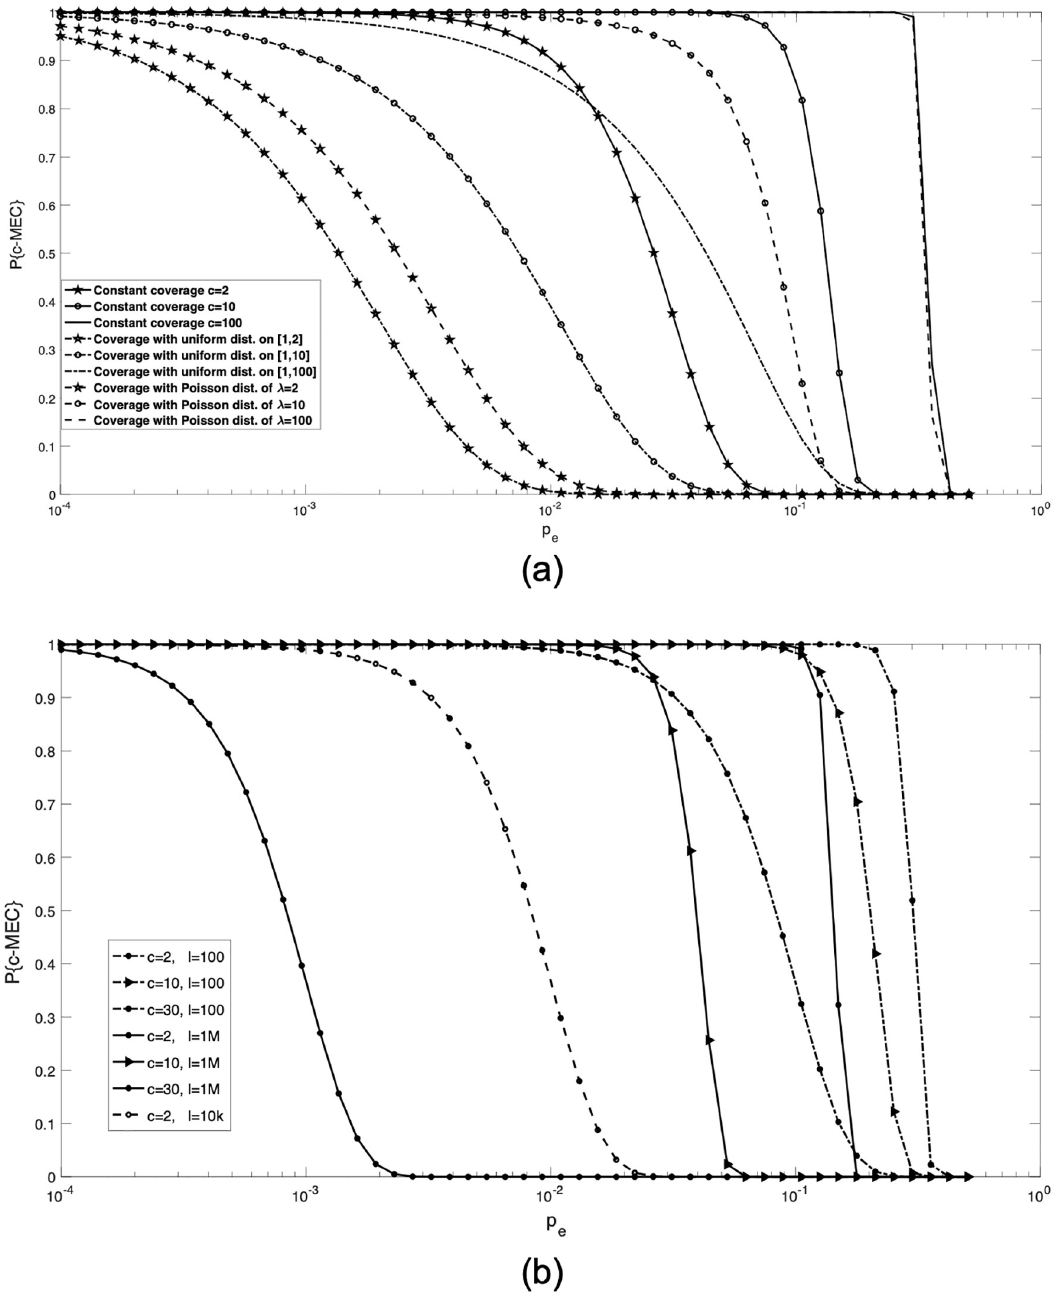
Fig 2. Performance curves of MEC approach. a: Comparison of P {c- MEC} for different coverage levels (constant c = {2, 10, 100}, quasi-uniform over c = {[1, 2], [1, 10], [1, 100]} and Poisson distribution with mean λ = {2, 10, 100}). b: Comparison of P {c- MEC} for different haplotype lengths l = {100, 10 k , 1 M } and different coverage values c = {2, 10, 30}.